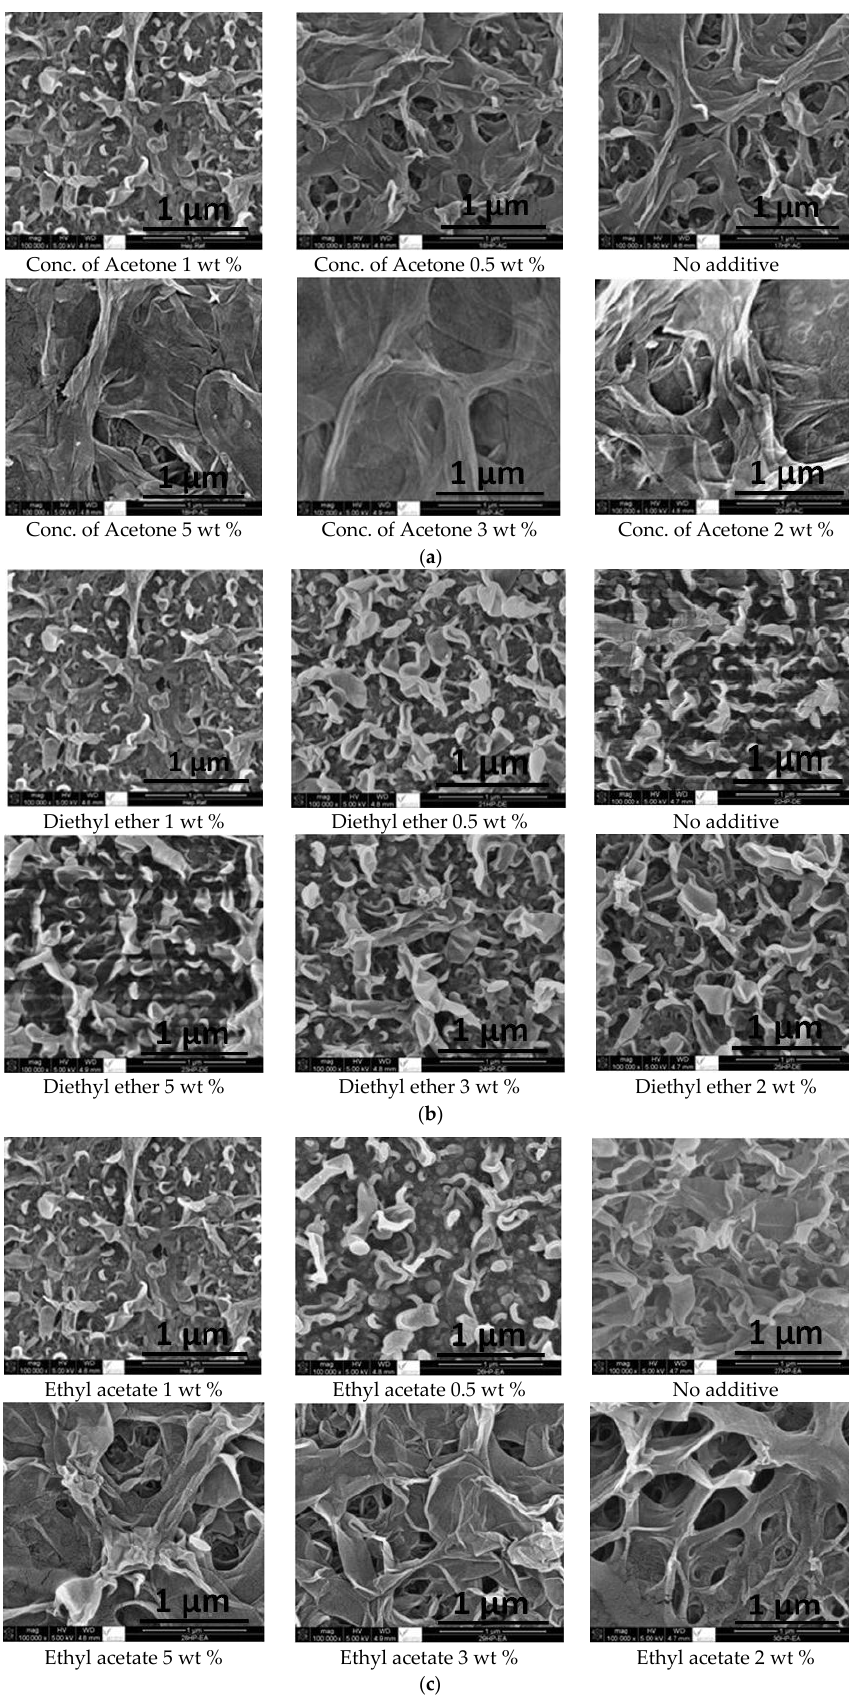
Figure 4. SEM images of the formulated membranes upon adding ( a ) acetone ( b ) diethyl ether ( c ) ethyl acetate. Dodecane Hexane